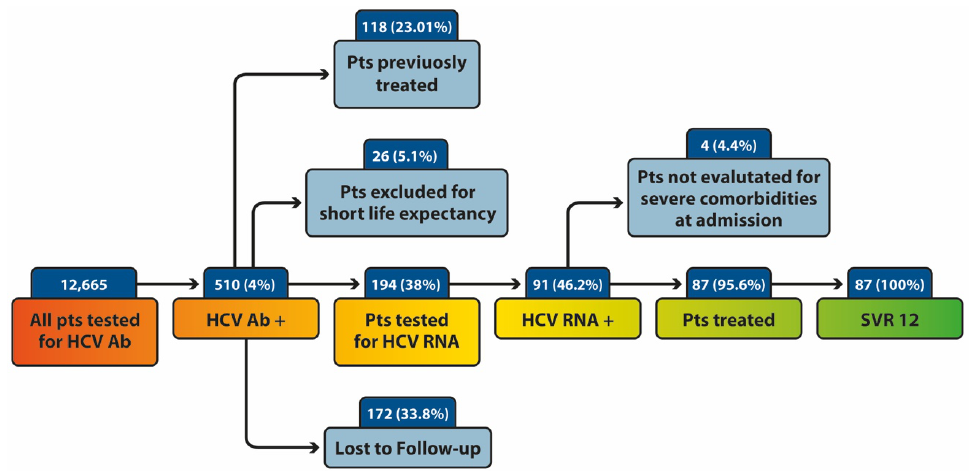
Figure 1. The flow chart of the study population. Pts: patients; SVR: Sustained Virological